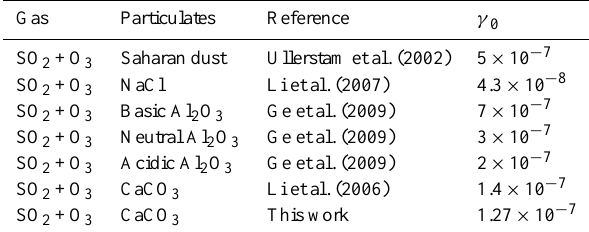
Table 1. Reactive uptake coefficients determined for SO 2 oxida- tion by O 3 on different particulates using a BET surface at room